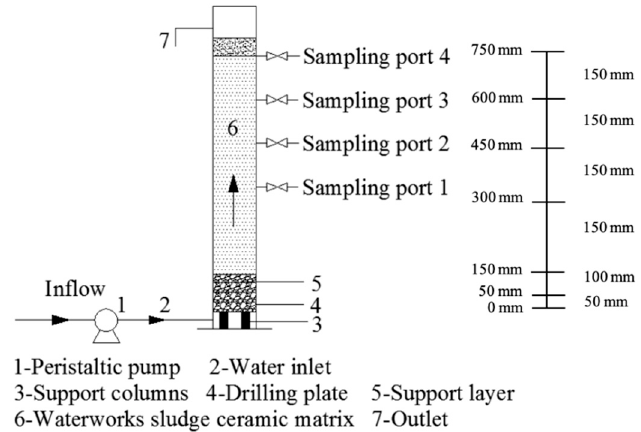
Figure 1. Schematic diagram of the experimental device for the constructed wetland.